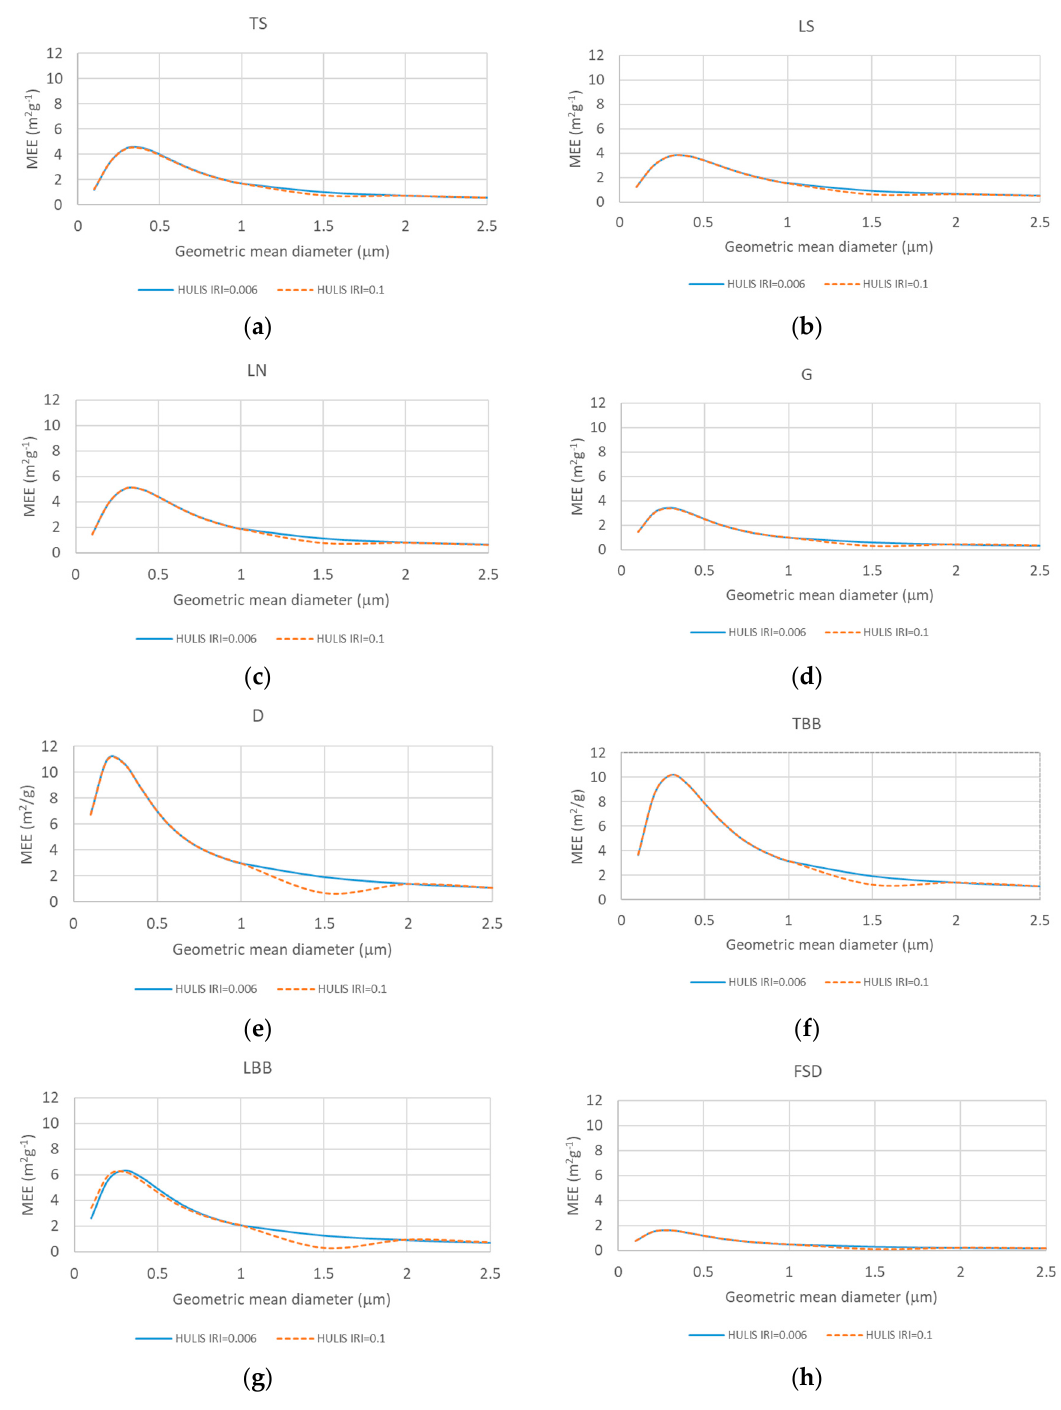
Figure 5. Composition-based mass extinction efficiency as a function of the geometric mean diameter for different humic-like carbon substance (HULIS) imaginary refractive indices (GSD = 1.5) for ( a ) TS, ( b ) LS, ( c ) LN, ( d ) G, ( e ) D, ( f ) TBB, ( g ) LBB, and ( h ) FSD.